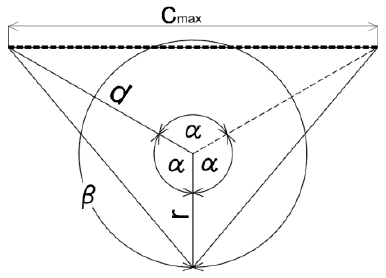
Figure 7. Maximum c values for α = 120 o , when β = 360 o , n = 3.